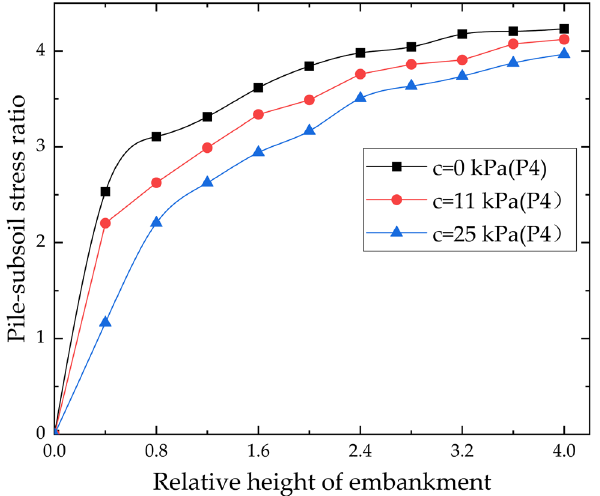
Figure 9. Effect of filling cohesion on pile-subsoil stress ratio, relative height of the embankment is h / ( s − a ) 4. FEM Numerical Analysis